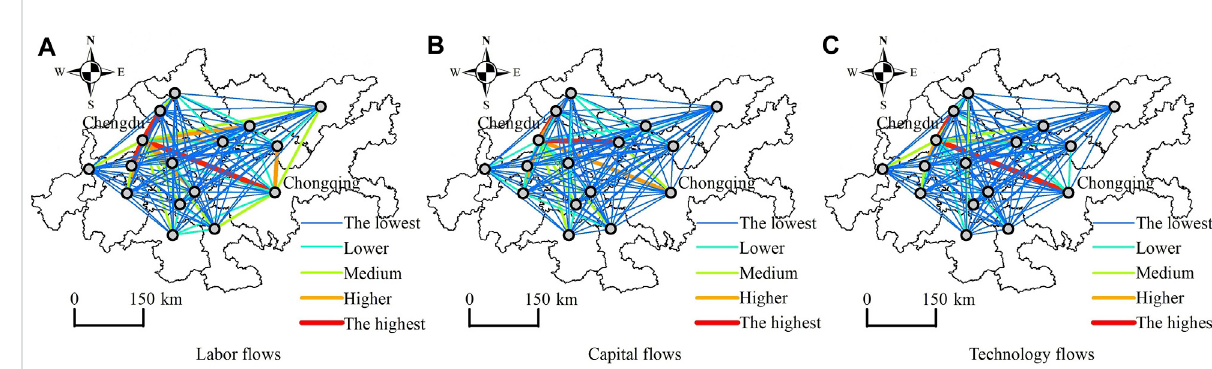
FIGURE 2 The intensity of labor, capital and technology fl ow calculated by multi-sources big data.